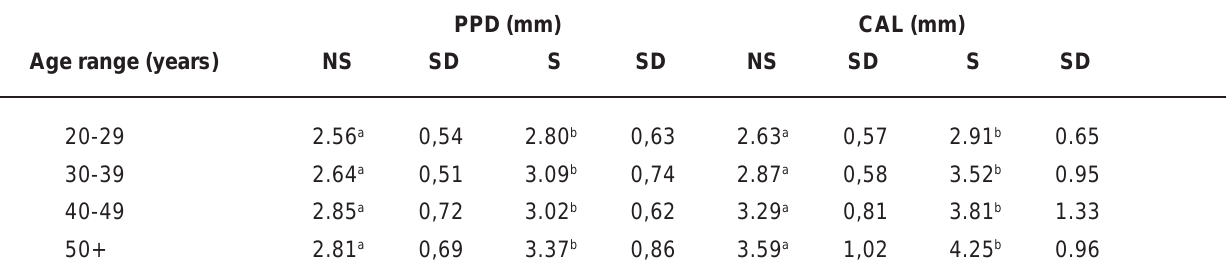
TABLE 5- Mean (SD) PPD and CAL in smokers (S) and non-smokers (NS) by age cohort. Statistically significant differences between smokers and non-smokers are shown with different letters